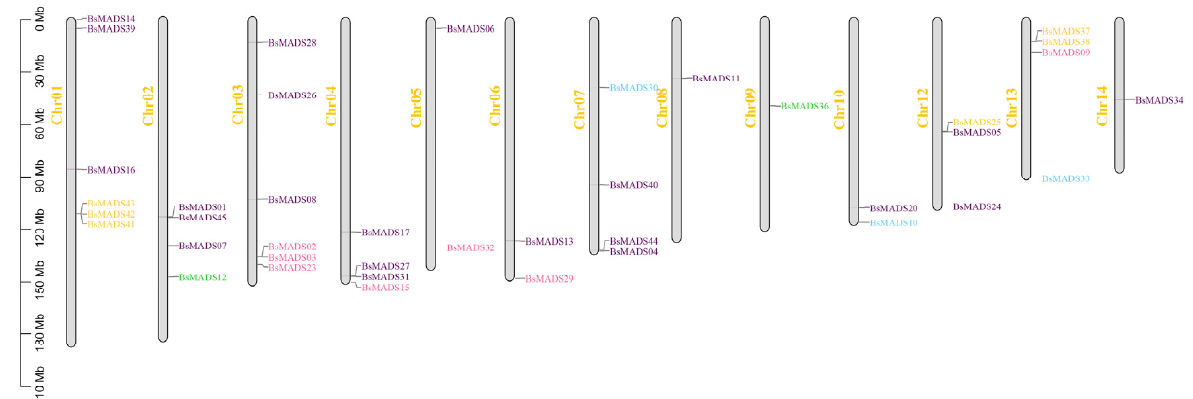
Figure 6. Chromosomal localization of 45 MADS genes in B. striata at the megabase (Mb) scale. The scale of five genes ( BsMADS18 , BsMADS19 , BsMADS21 , BsMADS22 , and BsMADS35 ) could not be anchored on a specific chromosome. The pink genes belong to group A (M α ), the yellow genes belong to group B (M β ), the green genes belong to group C (M γ ), the blue genes belong to group D (M δ ), and the purple genes belong to group E (MIKC).